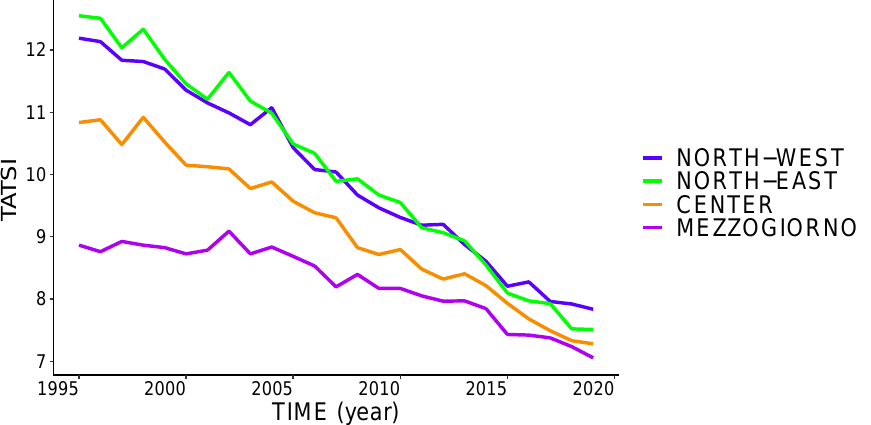
Figure 8. TATSI index for Italian population aged 65 from 1995 to 2019 across macroareas (NUTS-1 level). Source: the author’s own elaboration on data from